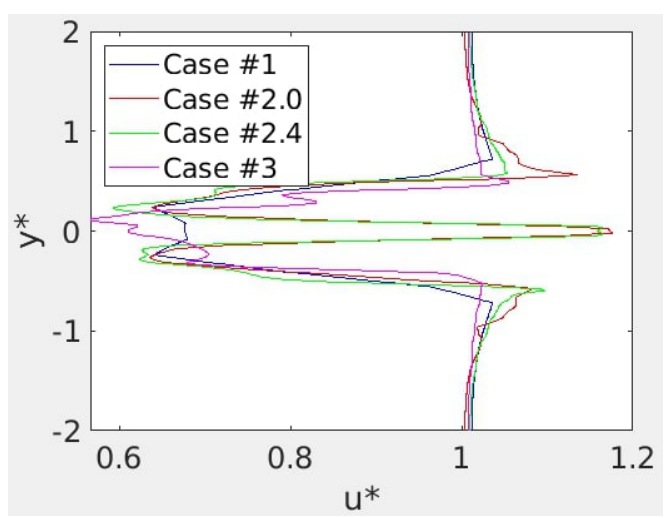
Figure 14. Same legend as previous one but for x ∗ =